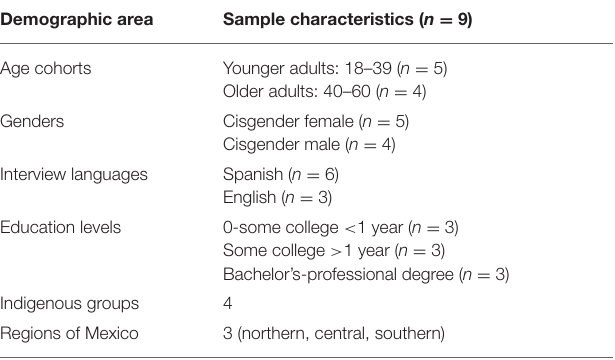
TABLE 1 | Demographics of the participant